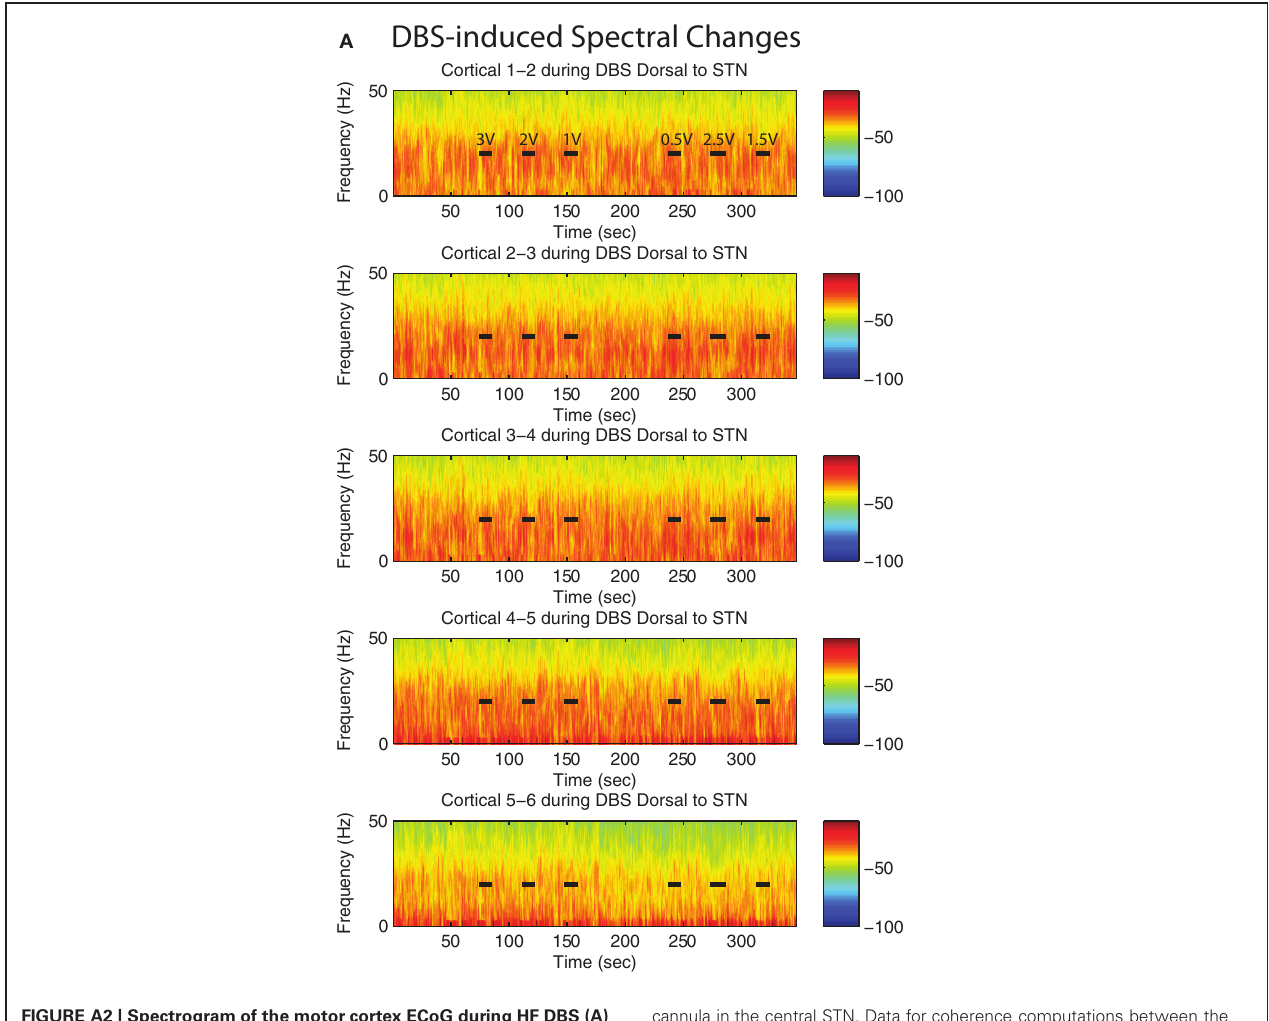
FIGURE A2 | Spectrogram of the motor cortex ECoG during HF DBS (A) 1mM dorsal to the STN, and (C) within the central STN of patient case 8R. This patient’s ECoG strip was placed ∼ 1cm lateral to the intended target. (B) Magnitude of coherence between each cortical bipolar pair and the STN